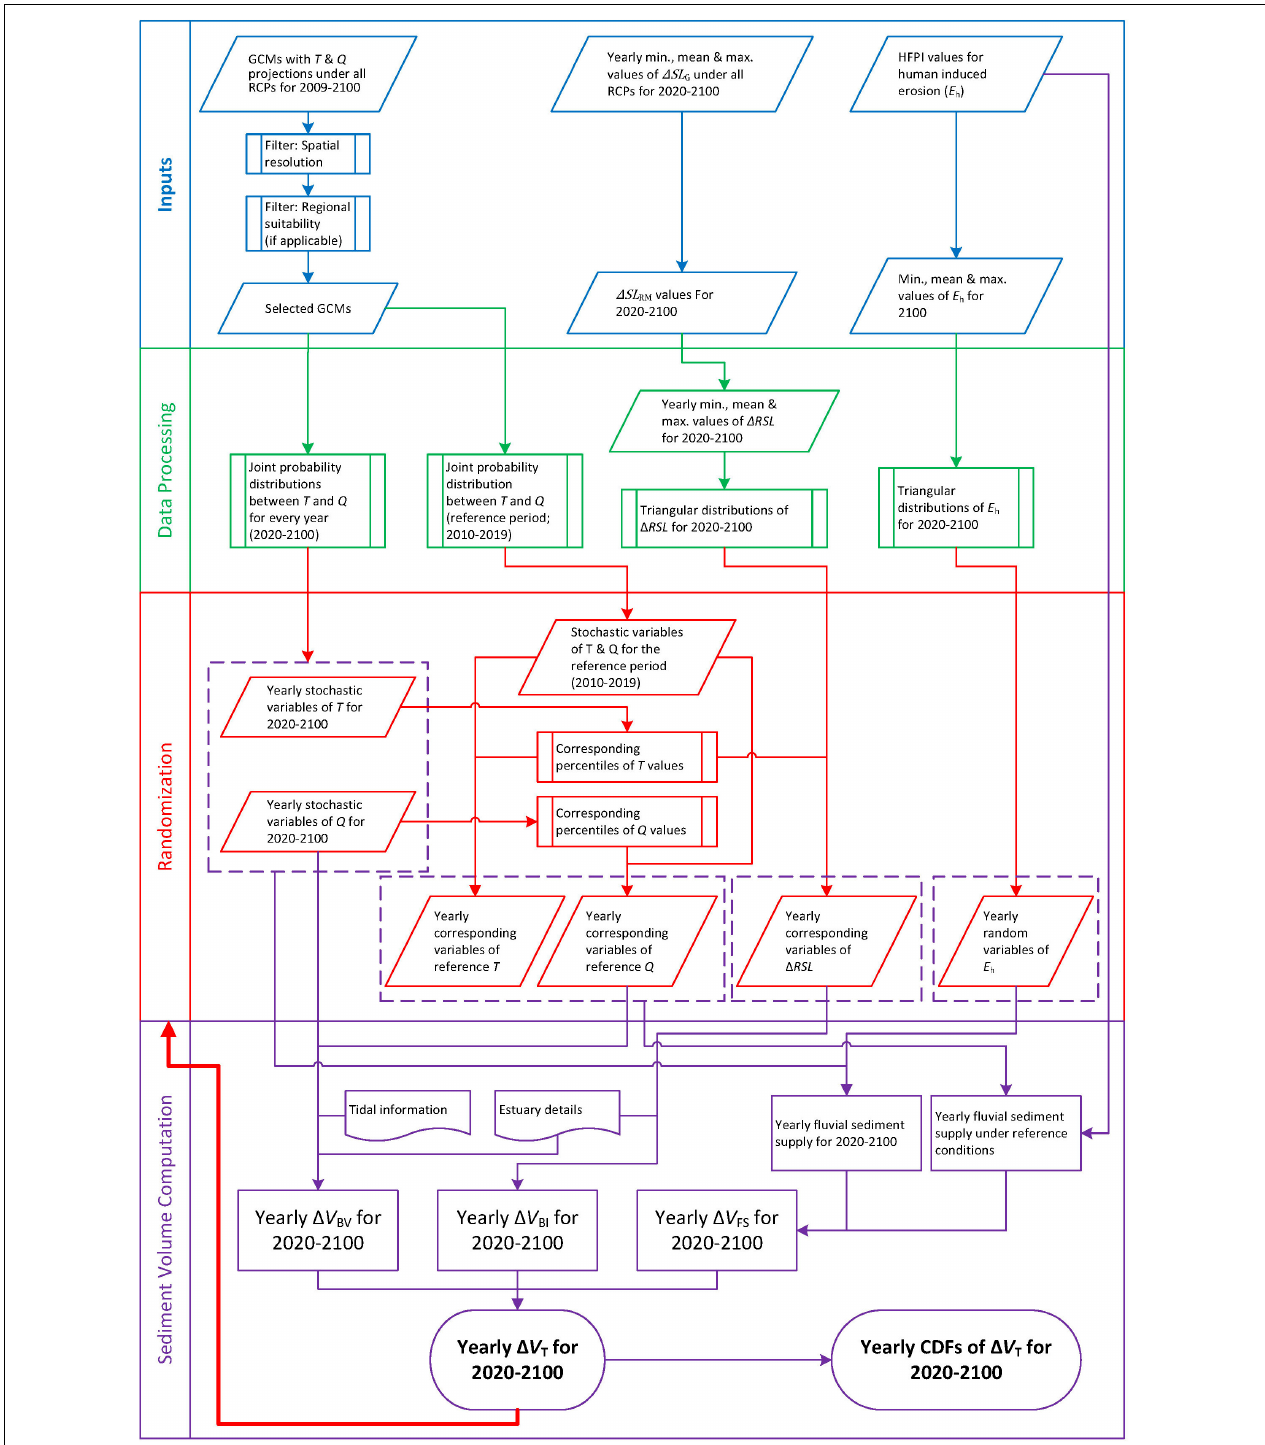
FIGURE 1 | Flowchart of the modeling approach adopted to probabilistically determine the change in total sediment volume exchange between an estuary system and its adjacent inlet-interrupted coast.